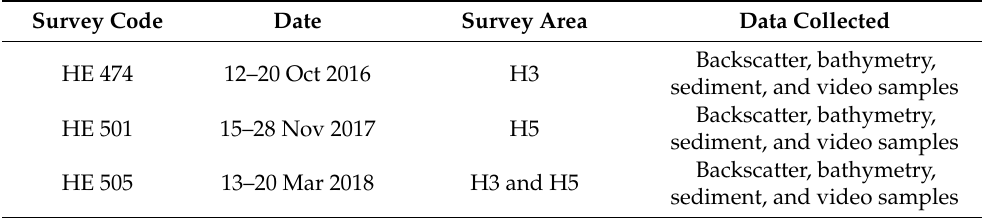
Table 1. Date of offshore surveys conducted with the German research vessel “Heincke” and the data collected.